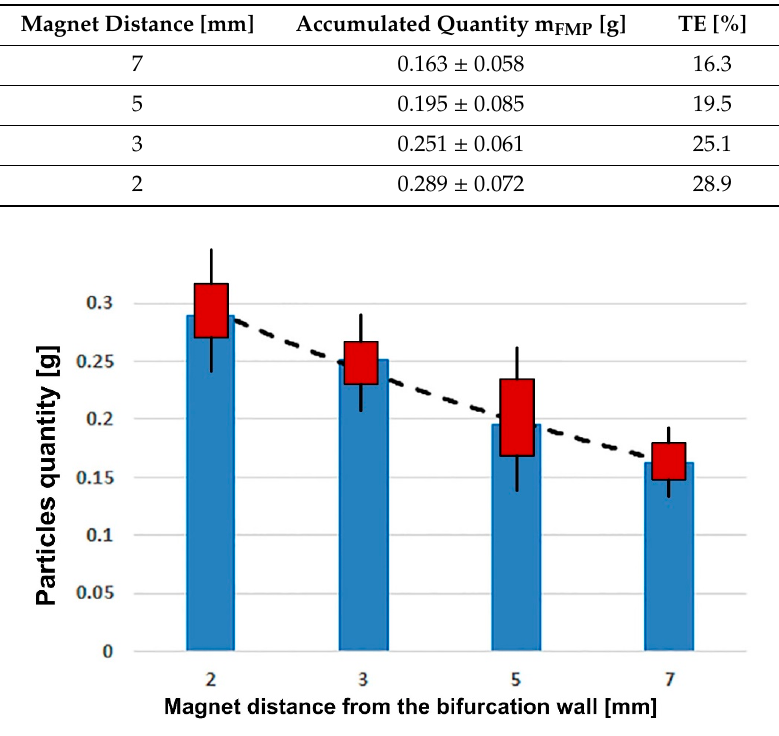
Table 8. Targeting e ffi ciency (TE) in the artery bifurcation model for di ff erent magnet distances.